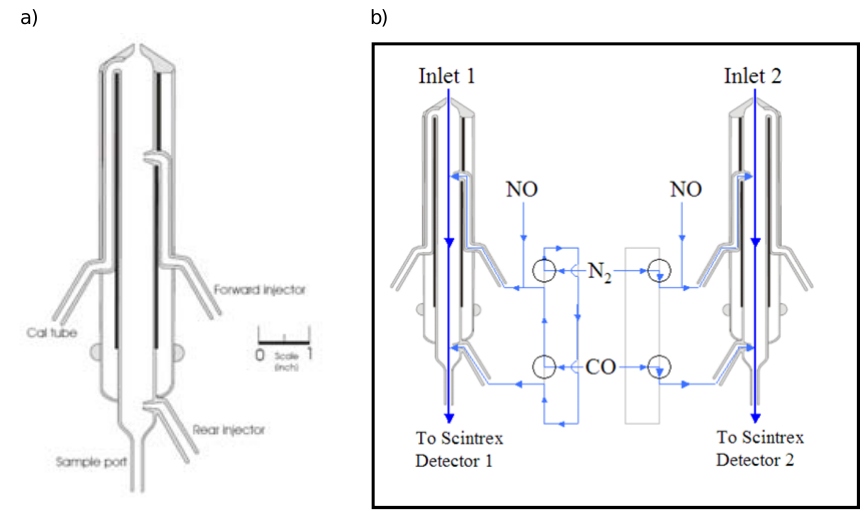
Fig. 2. (a) Scale diagram of aircraft inlet and (b) PeRCA 4 dual inlet scheme: Inlet 1 in chain amplification mode (NO and CO addition at front port, N 2 at back), Inlet 2 in background measurement mode (NO and N 2 addition at front port, CO at back), arrows indicate direction of gas flow, circles indicate 2-way valves (from Brookes,